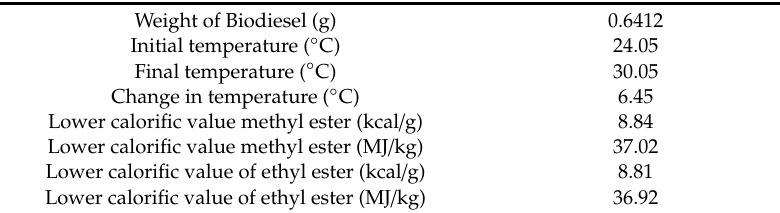
Table 6. Thermophysical parameters of